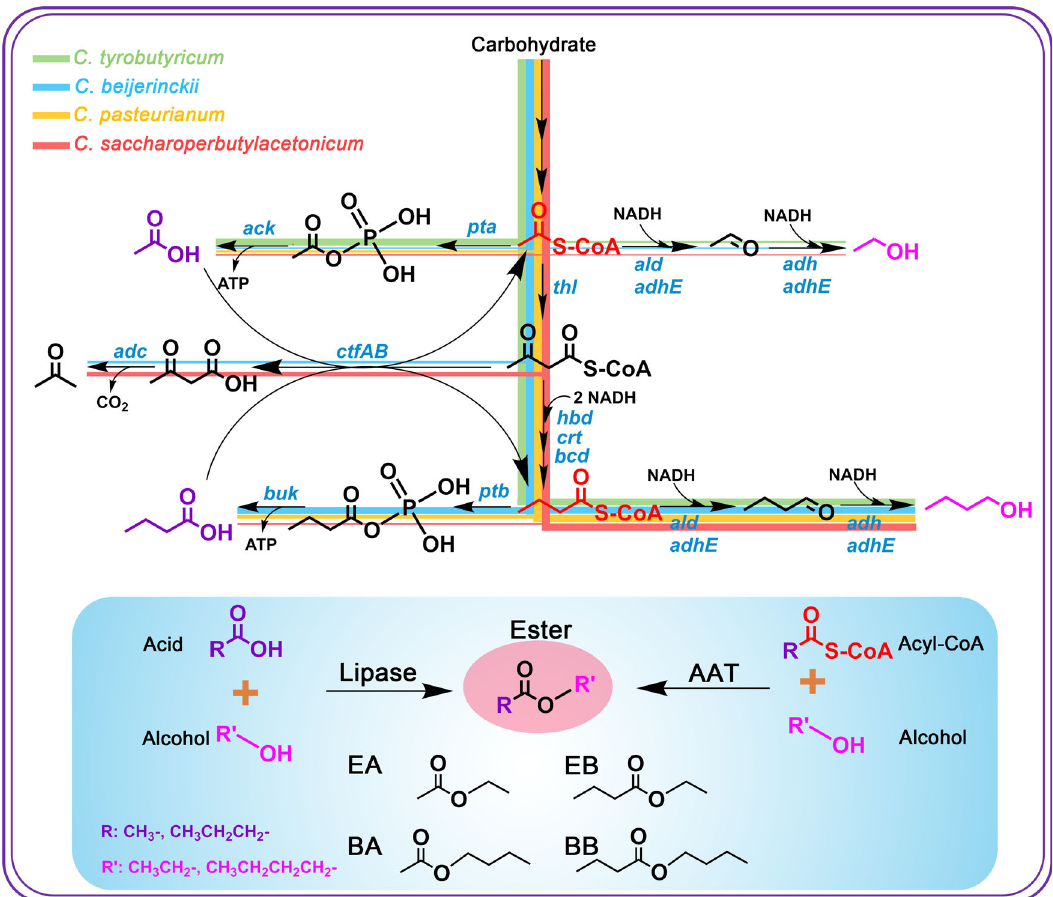
Fig. 1 Engineering of solventogenic clostridia for fatty acid ester production. Top: Five strains out of four representative clostridial species were selected and evaluated as the host to be engineered for ester production in this study. We hypothesized that the different metabolic fl uxes within different strains would make a big difference for the desirable ester production. The metabolic pathways of the four different species were represented in four different colors. Bottom: Fatty acid esters could be synthesized through two primary biological pathways: one is through the esteri fi cation of fatty acid and alcohol catalyzed by lipases, and the other is through the condensation of acyl-CoA and alcohol catalyzed by alcohol acyl transferases (AATs). Key genes in the pathway: pta phosphotransacetylase, ack acetate kinase, thl thiolase, hbd beta-hydroxybutyryl-CoA dehydrogenase, crt crotonase, bcd butyryl-CoA dehydrogenase, adh alcohol dehydrogenase, adhE aldehyde-alcohol dehydrogenase, adc acetoacetate decarboxylase, ctfAB CoA transferase, ptb phosphotransbutyrylase, buk butyrate kinase , ald aldehyde dehydrogenase. EA: ethyl acetate, EB: ethyl butyrate, BA: butyl acetate, BB: butyl